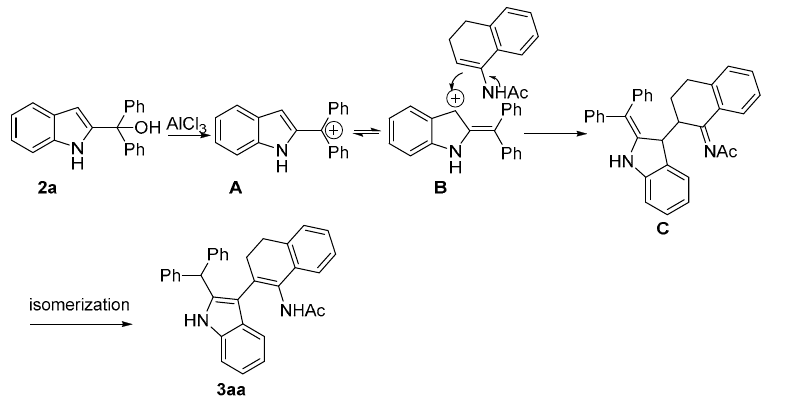
Scheme 1. Gram-scale experiment for the synthesis of 3aa .